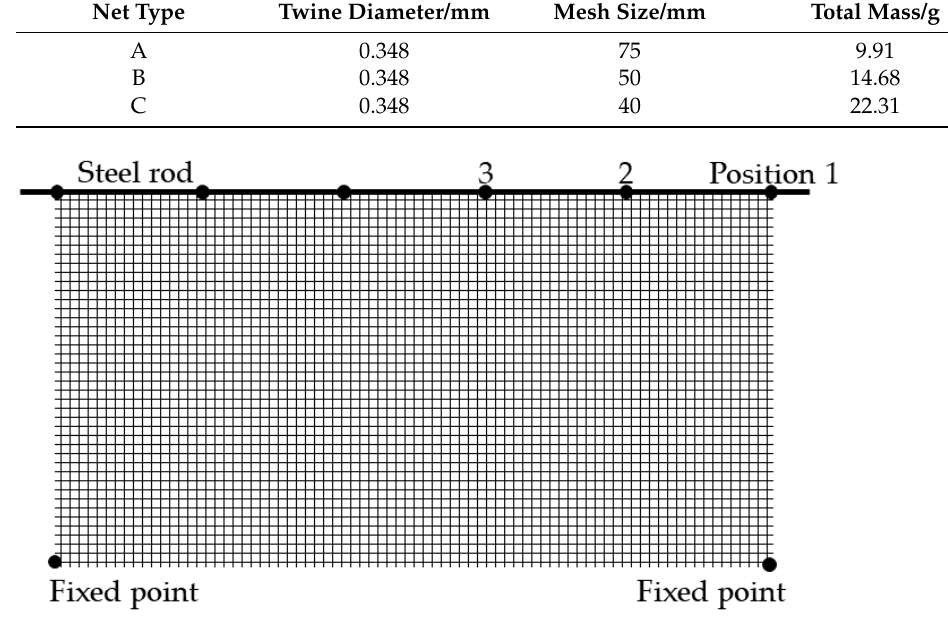
Figure 7. The diagram of the validation